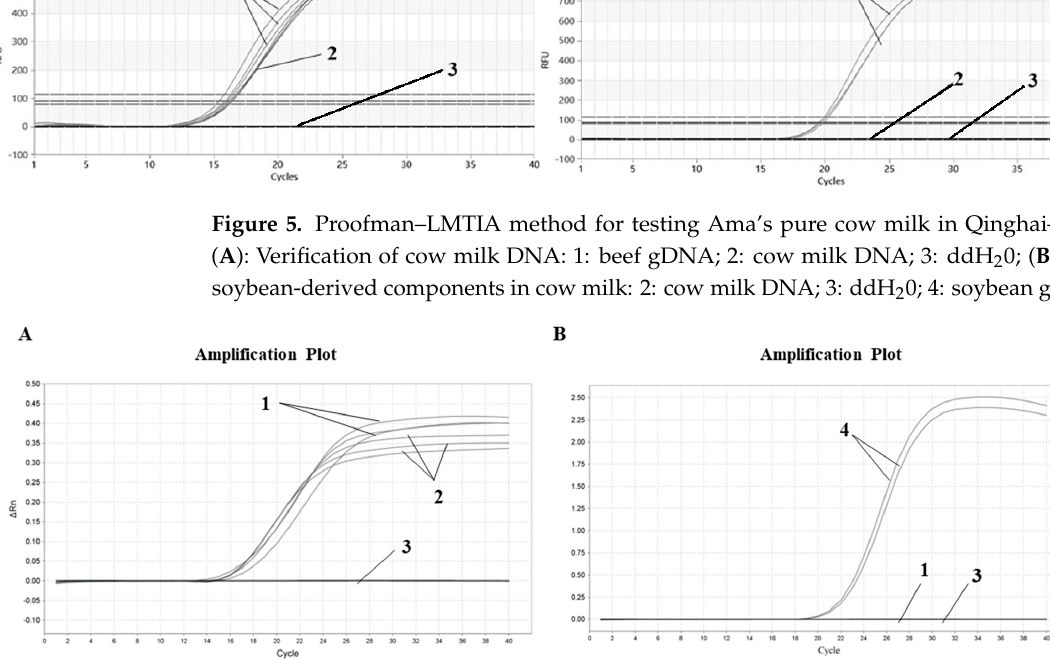
Figure 6 . Proofman–LMTIA method for detection of Jomilk selected pure goat milk. ( A ): Verification of goat milk DNA: 1: goat milk DNA; 2: mutton gDNA; 3: ddH 2 0; ( B ): Detection of soybean-derived